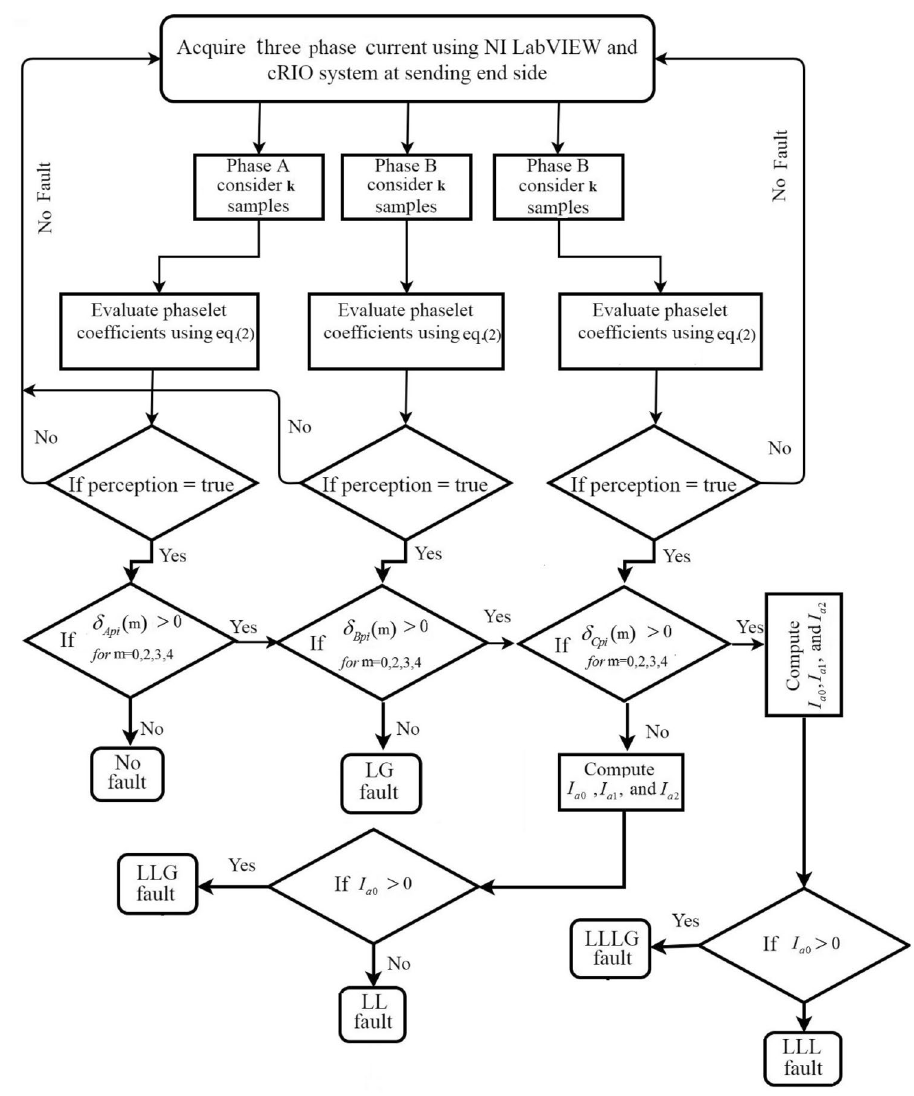
Fig. 4 Flowchart for compre- hension of